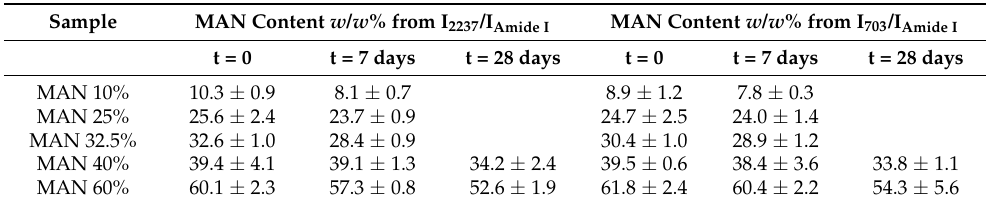
Table 1. MAN content w / w % as calculated from the linear regression of Raman I 2237 /I Amide I and I 703 /I Amide I of the grafted silk fibers under study before and after immersion in SBF for 7 and 28 days. The data are expressed as the average of three measures ± their standard